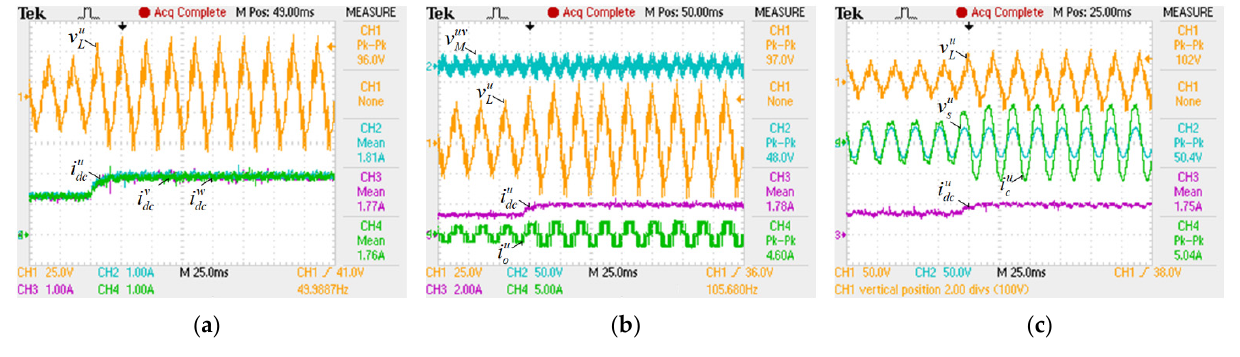
Figure 8. Performance for DC current change; ( a ) load voltage (CH1), DC currents in each cell (CH2, CH3, and CH4); ( b ) load voltage (CH1), magnetic coupling voltage (CH2), DC current (CH3), PWM output current (CH4); ( c ) load voltage (CH1), cell input currents and cell input voltage (CH2 and CH4) and DC current (CH3).